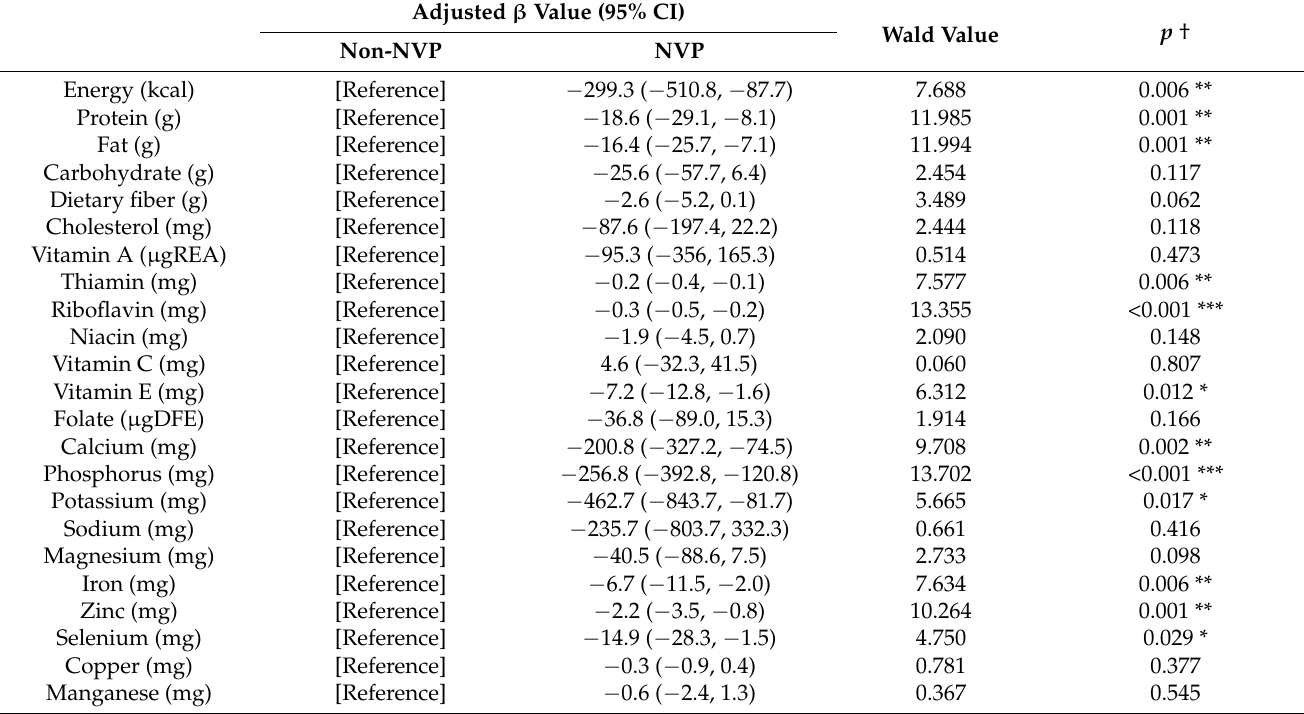
Table 3. Comparison of dietary nutrient intake between the NVP and non-NVP groups after adjusting for demographic